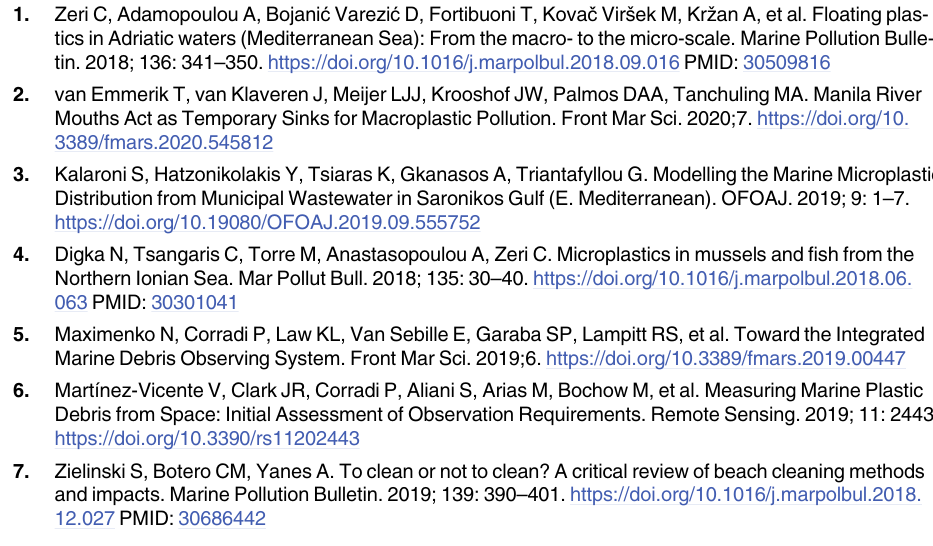
S1 Fig. Features correlation. (A) Agglomerative hierarchical clustering on Spearman Correla- tion. (B) Heatmap of features